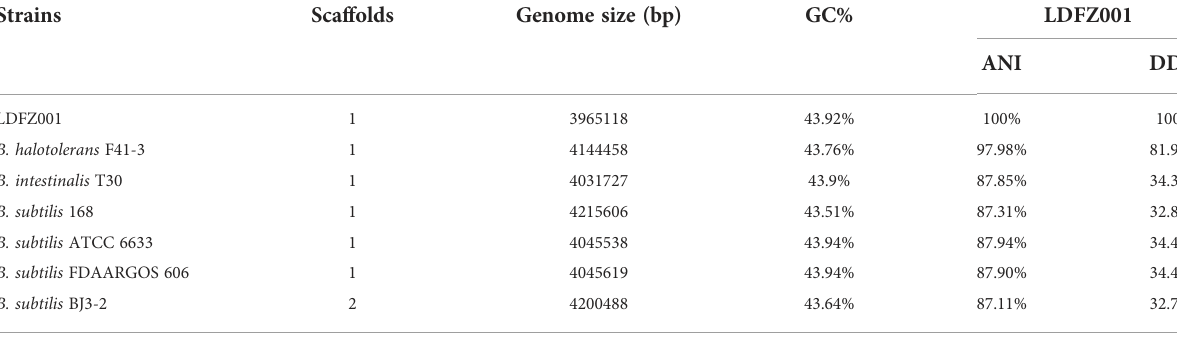
TABLE 1 Comparison of genome information between LDFZ001 and its six closest Bacillus species.